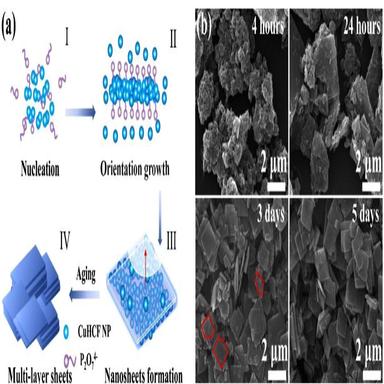
The formation process and mechanism of the CuHCF-P multi-layer sheets. (a) Schematic illustration of the formation mechanism of multi-layer sheets: I. CuHCF nanoparticle formation during the nucleation process; II. Pyrophosphate absorbed on the CuHCF NP induces the two-dimensional growth and aggregation of CuHCF NPs; III. Formation of CuHCF-P Nanoplates; IV. The aging process and multi-layer sheets were fabricated. (b) SEM images of the samples obtained at 4, 24, 72, and 120 hours in the coprecipitation pro